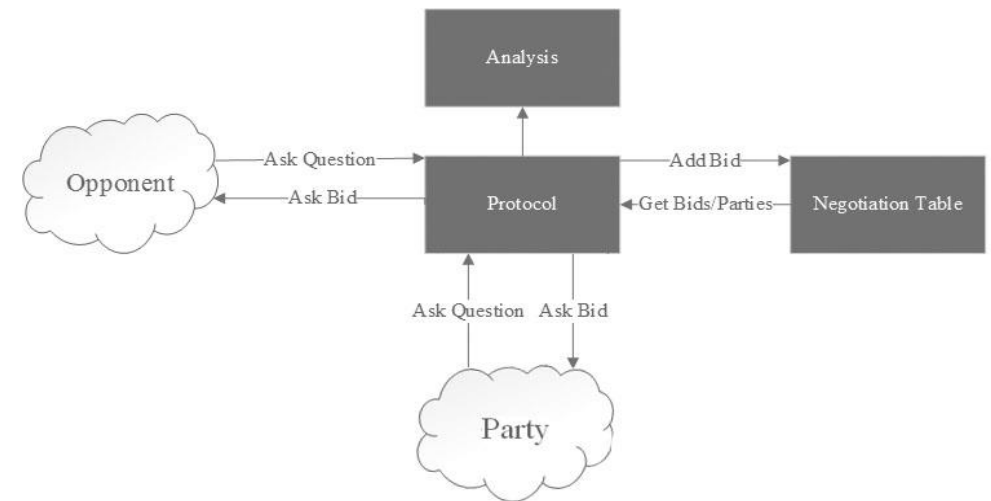
Figure 2. The NegoSim architecture. The protocol is the most important entity, controlling all communications. Rectangles represent a NegoSim entity. The analysis entity has access to the estimation part of each party, their preferences, and their offers on the negotiation table through the protocol.